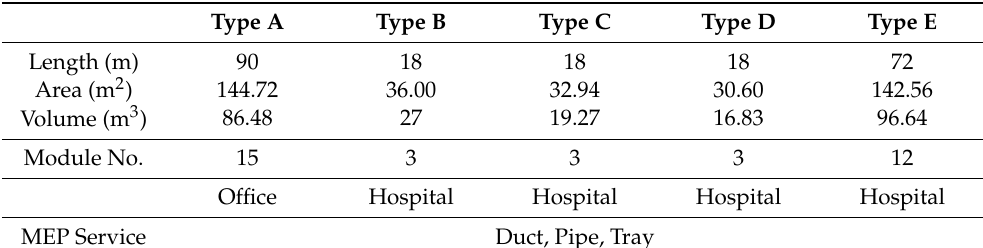
Table 1. Case Study (partially